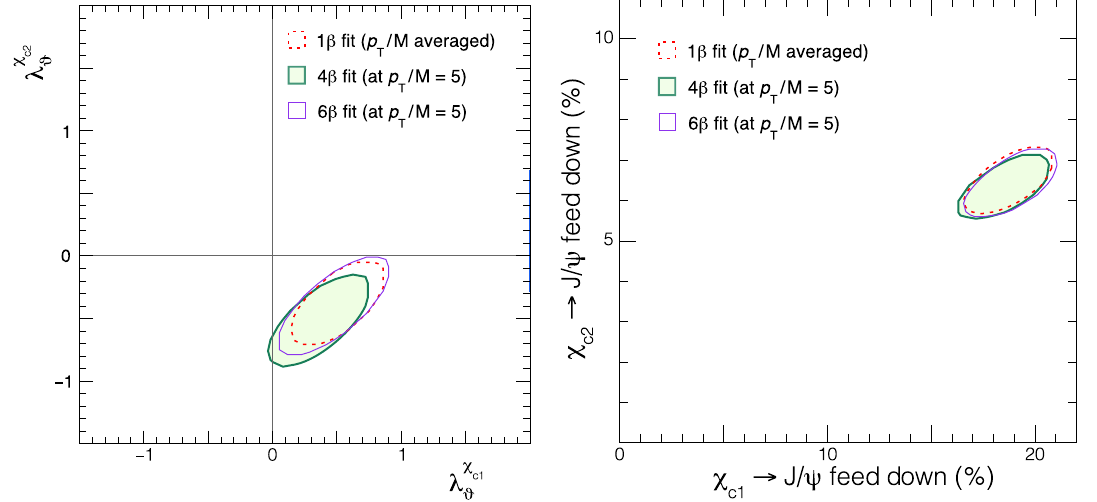
χ c 2 λ χ c 1 ϑ and ϑ polarizations (left) and between the